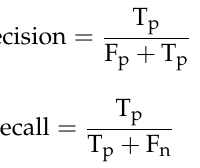
Figure 9. Original images and labeled images of the eyes in the dataset.